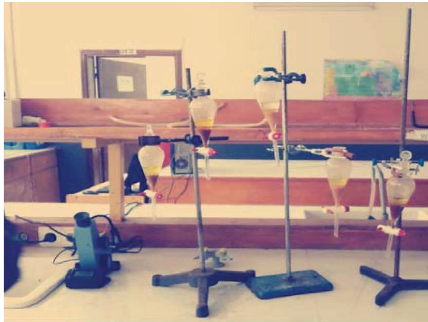
Figure 2: β -Carotene